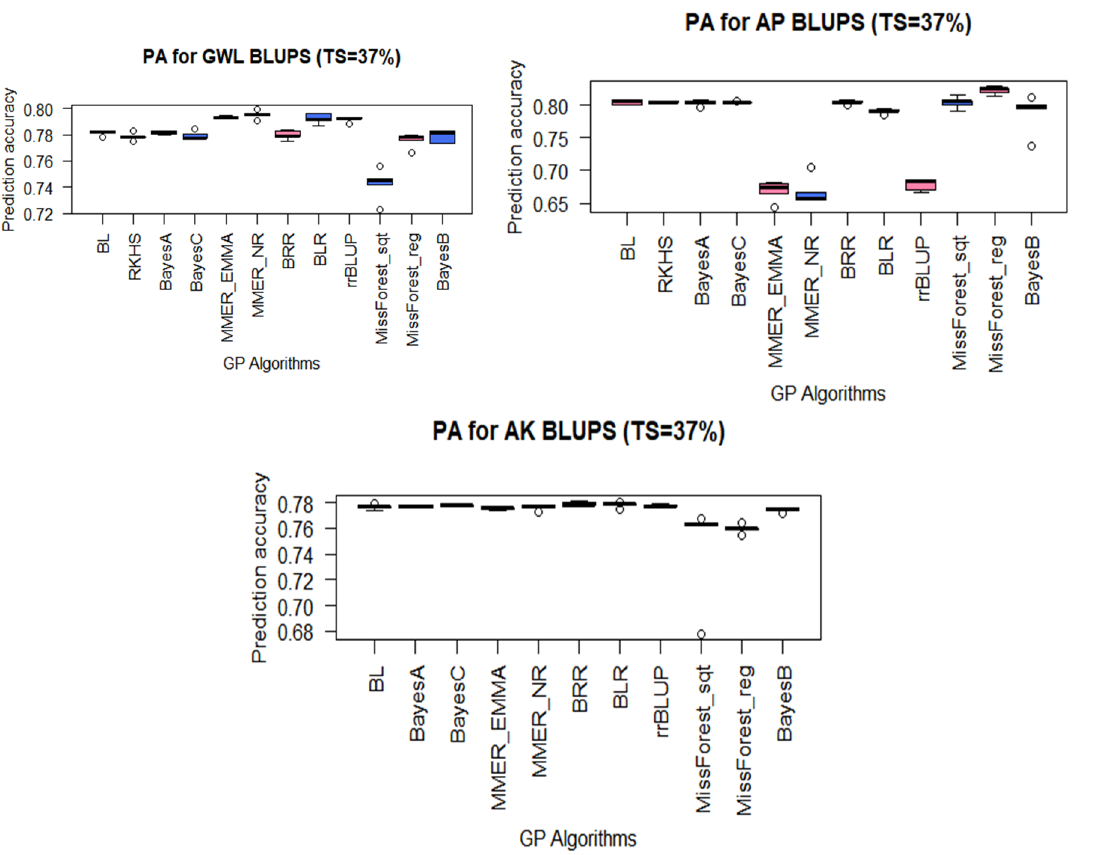
Figure 2. Boxplots of the genomic prediction accuracies of BLUPs for MW-resistance traits: GWL, grain weight loss; AP, adult progeny emergence; AK, number of affected kernels (See Table 3 for GP algorithms).